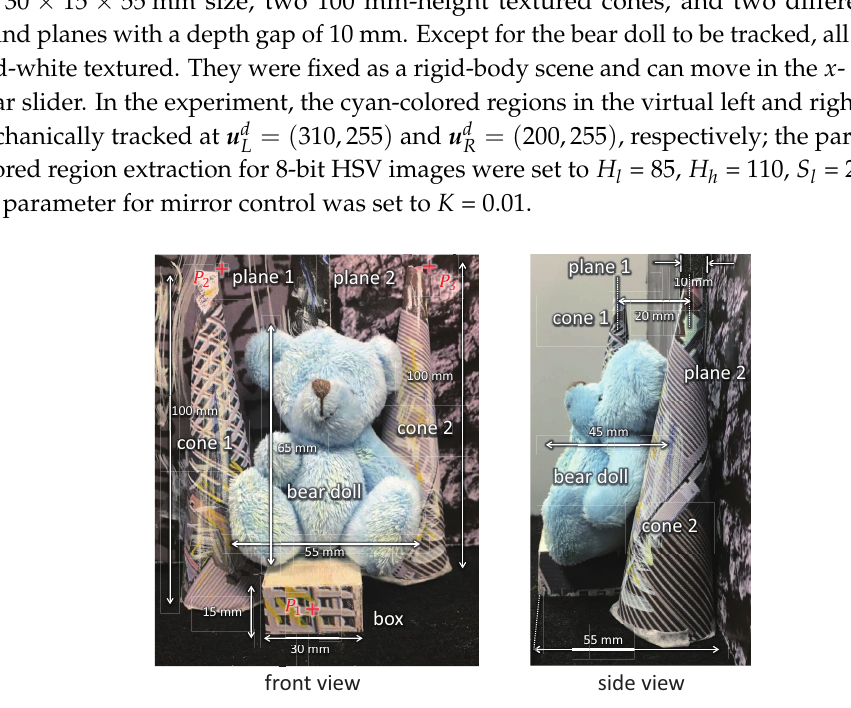
Figure 10. 3D scene to be